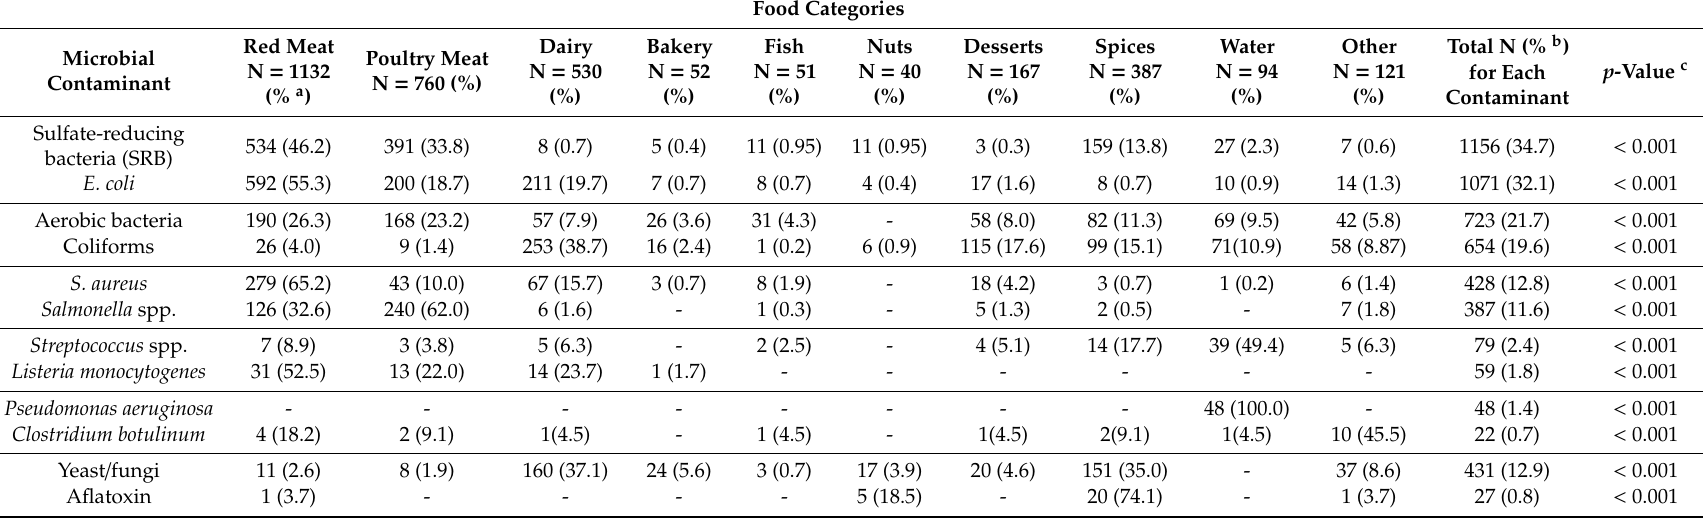
Table 4. The distribution of microbial contaminants that resulted in the rejection of samples across food category based on the reports of the Ministry of Public Health (MoPH) in